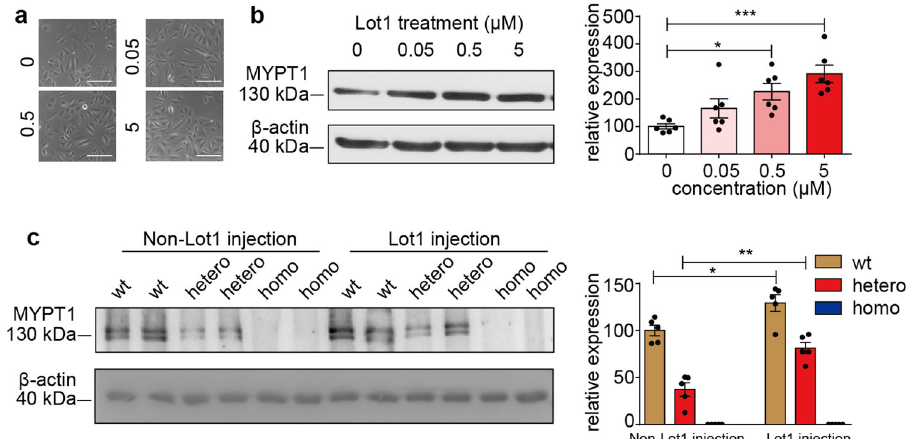
Fig. 5 MYPT1 expression was increased by lotusine treatment both in vivo and in vitro. a A7R5 cells showed normal morphology after incubation with different doses of lotusine, which showed no cytotoxicity. b A7R5 cells were treated with lotusine in vitro for 24 h, and cell lysates were then subjected to Western blotting for MYPT1 measurement ( n = 6) ( One-way ANOVA ). c , Mypt1 + / + Mypt1 + / Δ SM Mypt1 Δ SM/ Δ SM mice were injected in vivo with lotusine (5 mg/kg), and MYPT1 protein expression in the penises was measured by Western blotting. Protein data were analyzed with β -actin as the internal control ( n = 5) ( t- test). The bars indicate the mean values ± SEM; * p < 0.05, ** p <